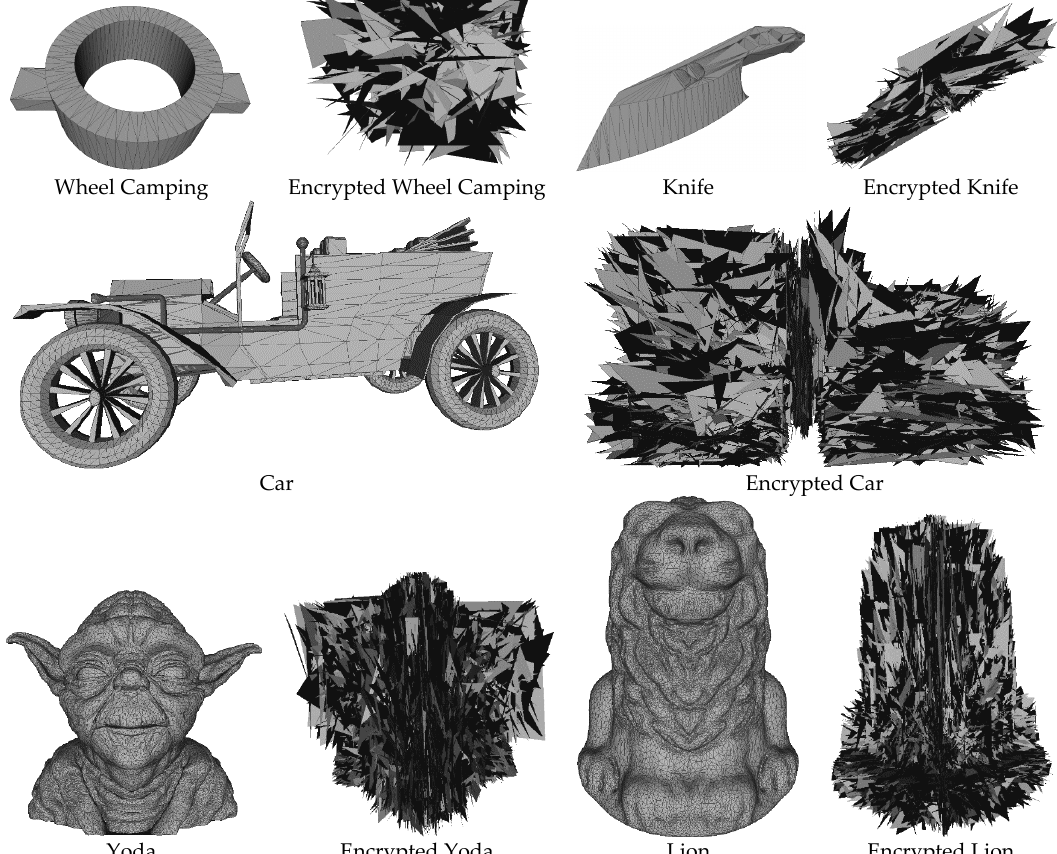
Figure 5. Experimental results with test models.